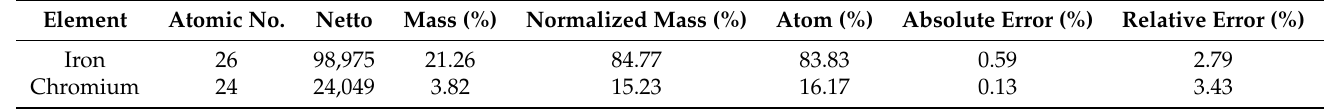
Table 2. Elemental analysis of the steel spring by EDX. Percentage of elements present in steel spring